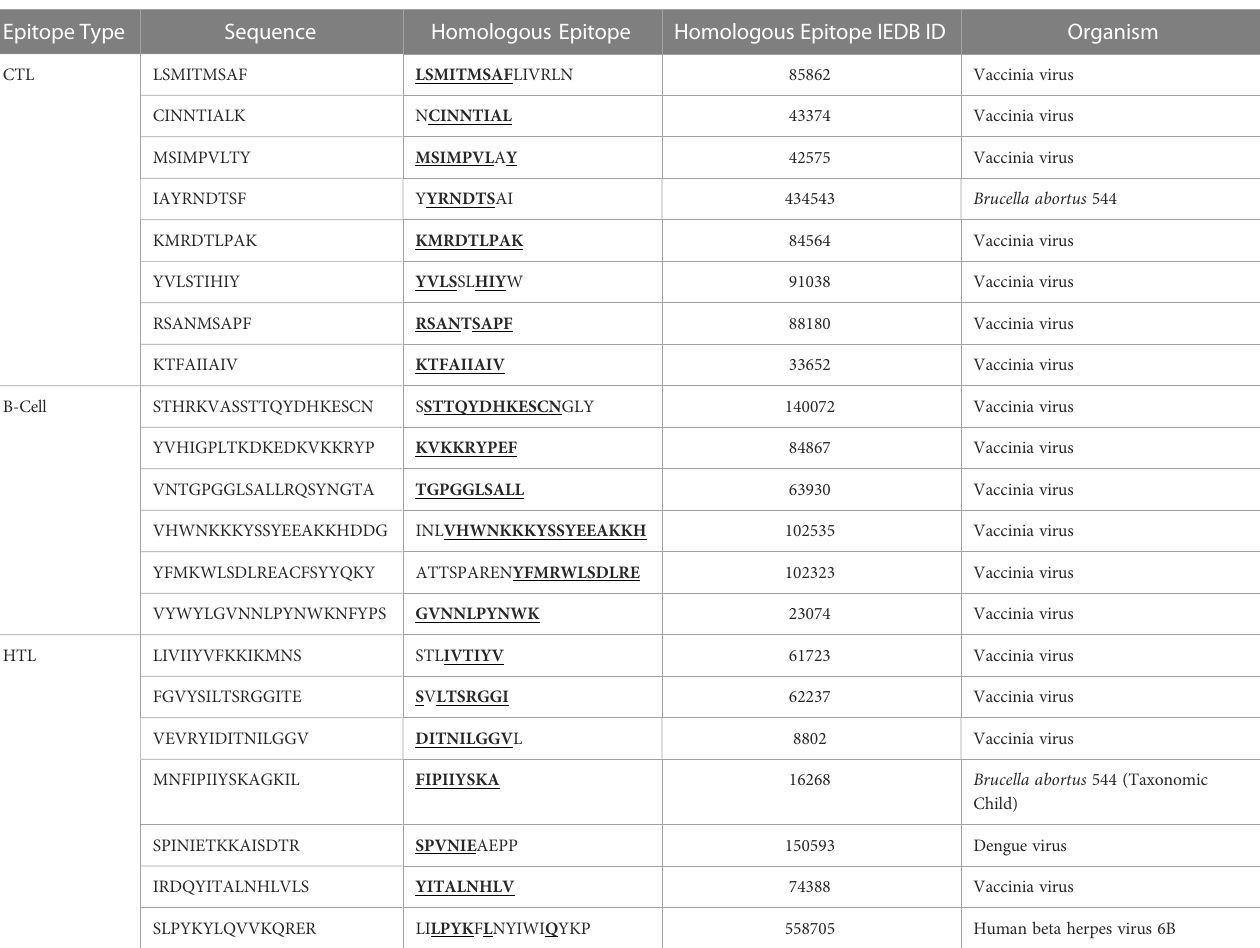
TABLE 5 Homology of selected B-cell and T-cell peptides with experimentally validated epitopes of other pathogens (homologous epitopes at ≥ 70% identity). Epitope Type